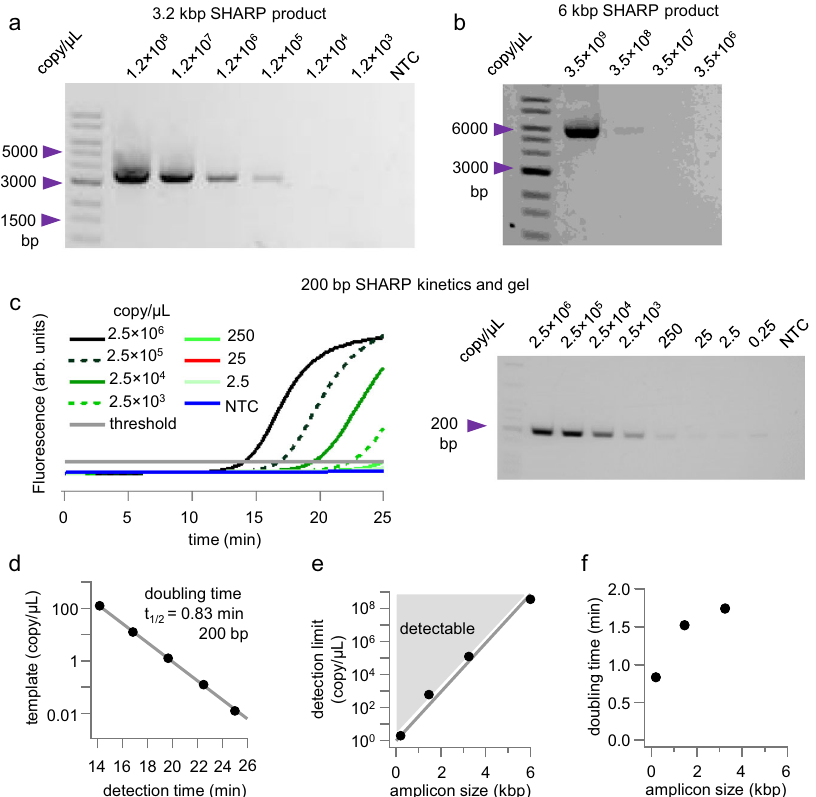
Fig.3|OtherSHARPproducts.a 3kbpSHARPamplicon. b 6kbpSHARPamplicon. c 200bp SHAR amplicon using λ DNA as a template. d SHARP doubling time esti- mate for 200bp product. e Detection limit versus the amplicon length. The area above the detection limitisshaded in grayand labeled detectable. f Doubling time